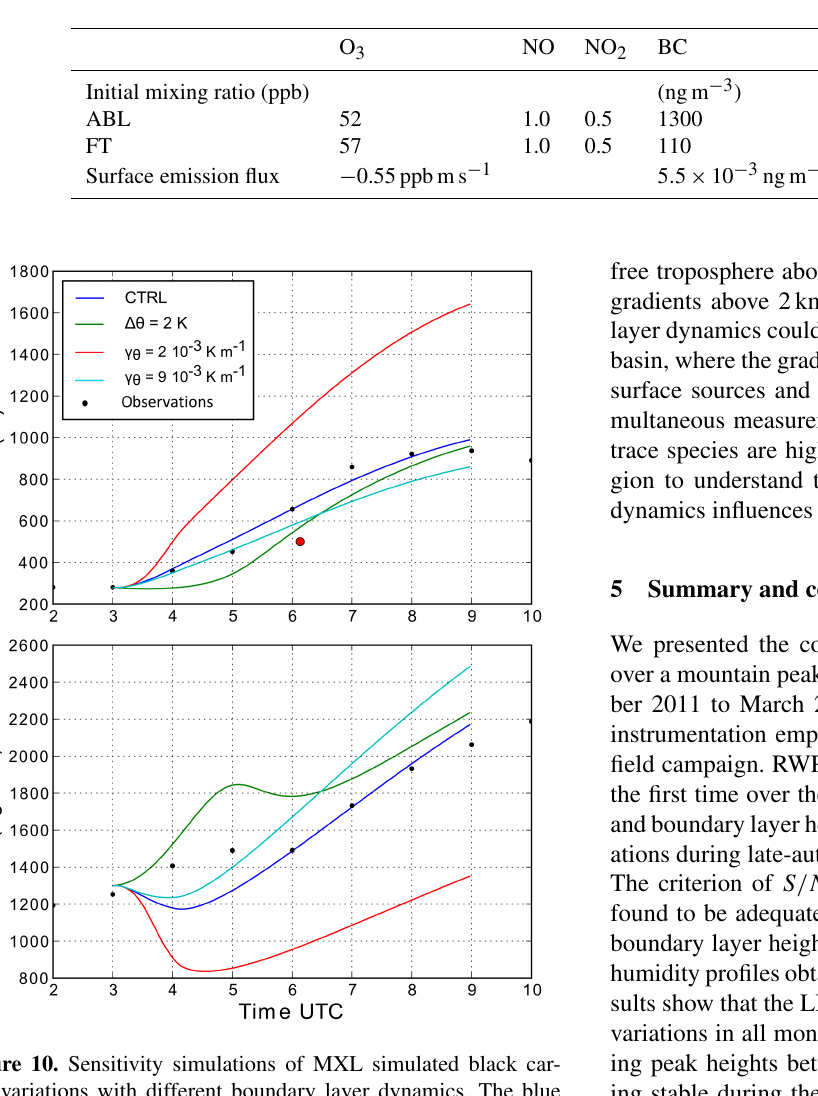
Table 4. Initial mixing ratio in ABL and FT, and surface emission fluxes of the reactants for MXL/MESSy runs. Species in the reaction mechanism that are not included in this table have an initial concentration of zero and no surface emissions. For O 2 and N 2 we have imposed the values 2 × 10 8 and 8 × 10 8 ppb, respectively.